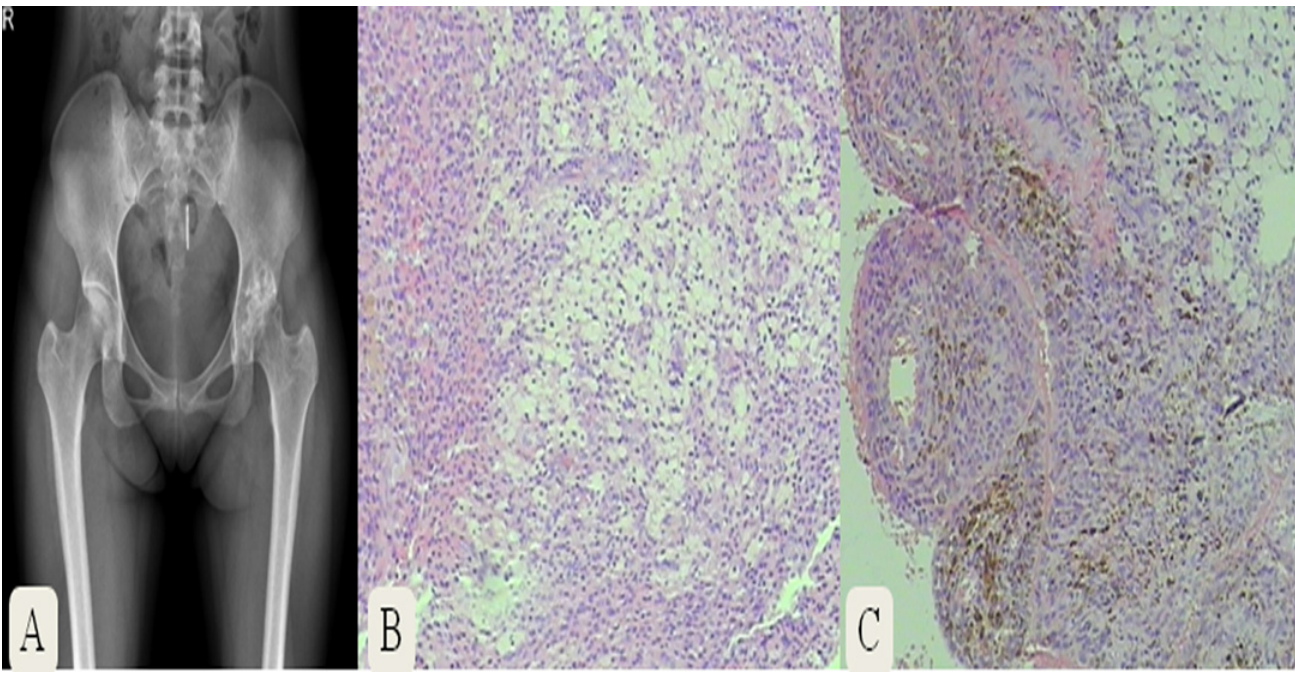
Fig 6. Radiograph and histopathological images of a 31-year-old female diagnosed with left hip PVNS. (Table 4). In addition, no significant recurrence difference was identified between patients that